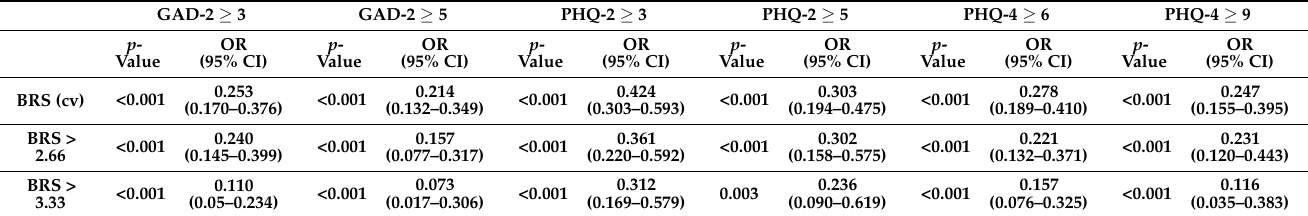
Table 7. Influence of resilience on self-reported mental health outcomes (univariate logistic regression